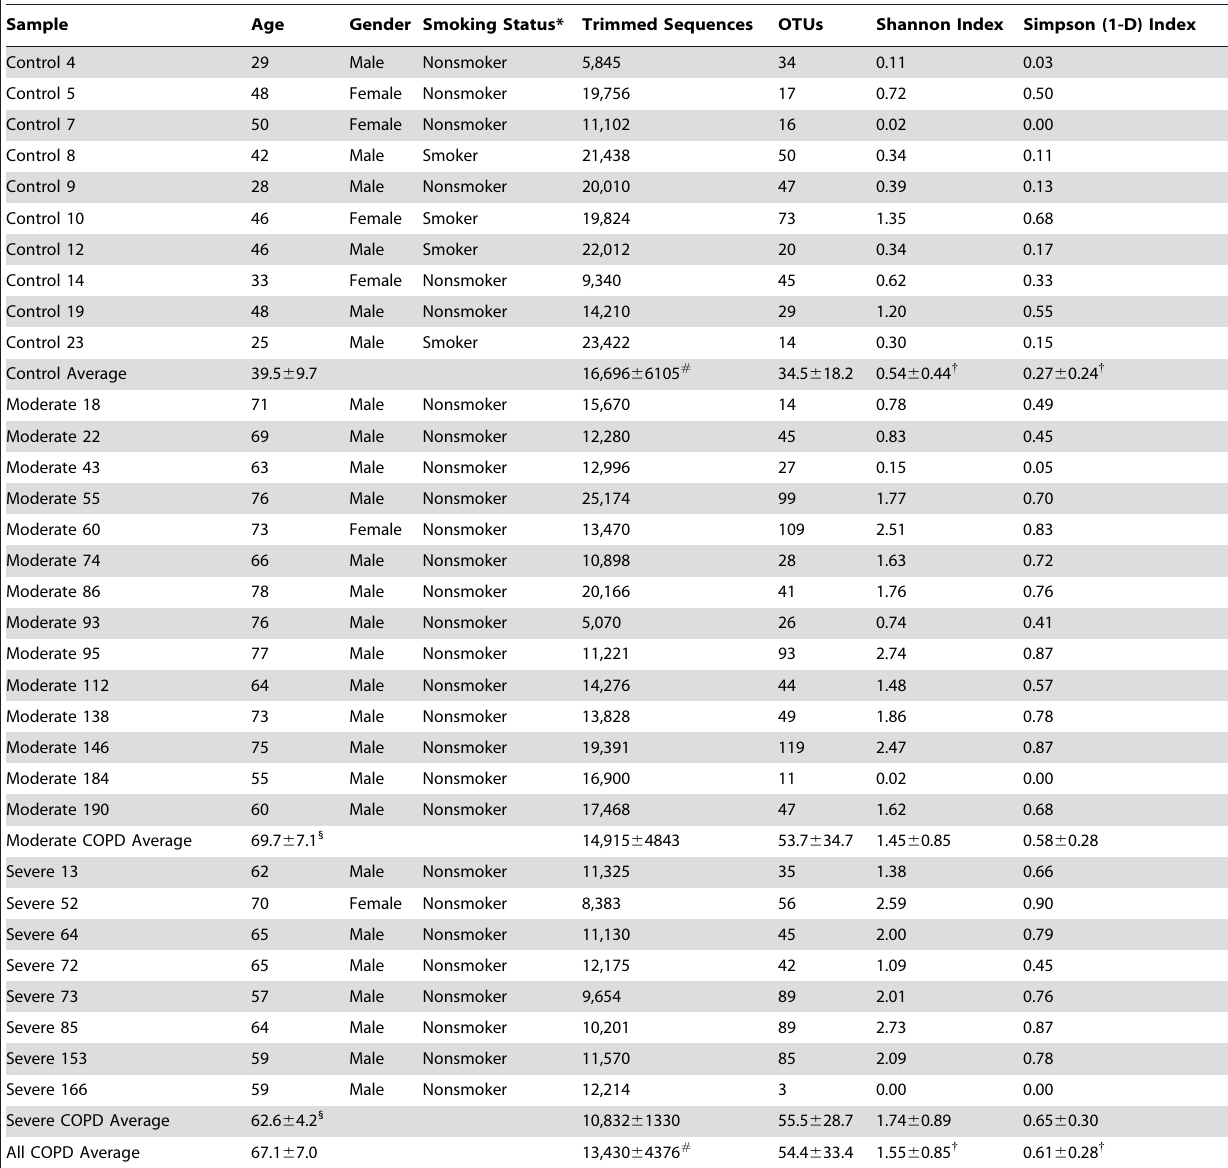
Table 1. Patient Characteristics and Sequencing